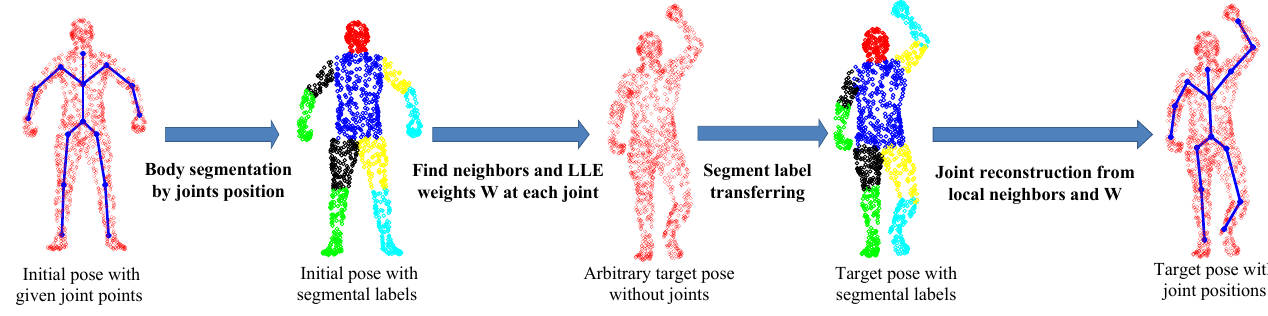
Figure 8. Ground-truth generation of joint positions for SCAPE